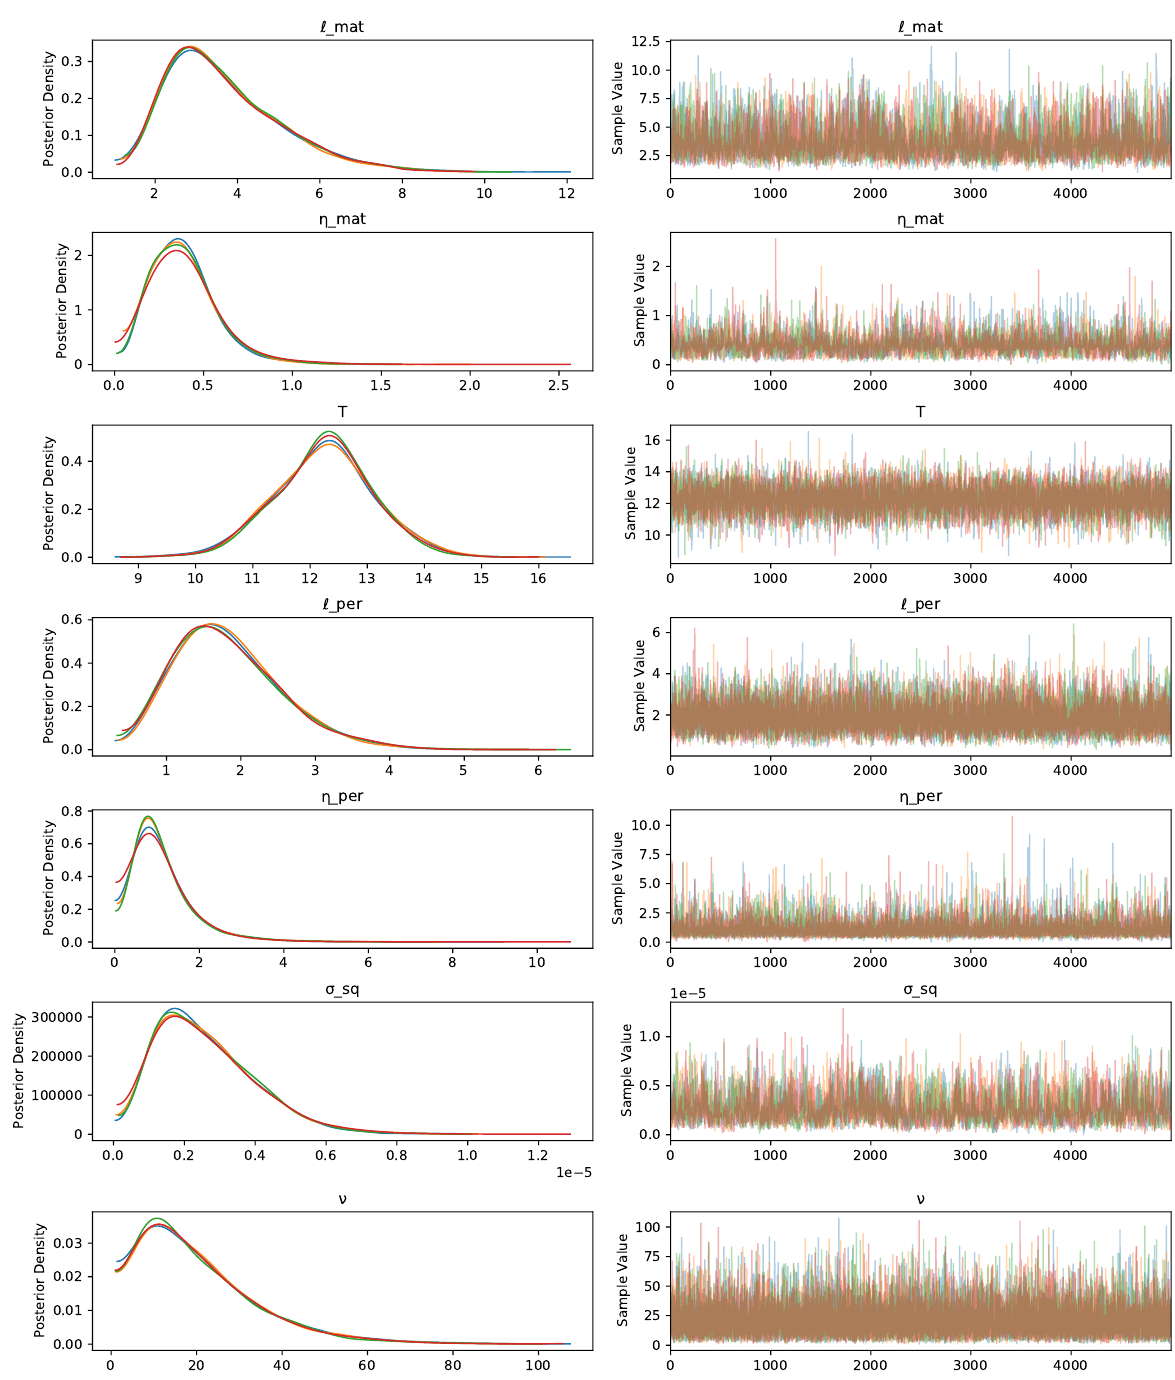
Figure 12. Posterior distributions and trace plots for the Blue Buttes Field VIIRS-NDIC scale factor model. Well mixing and convergence are achieved. Note the differences between these results and those in Figure 10, both of which are based on the same priors and likelihood, demonstrating the model specification’s wide